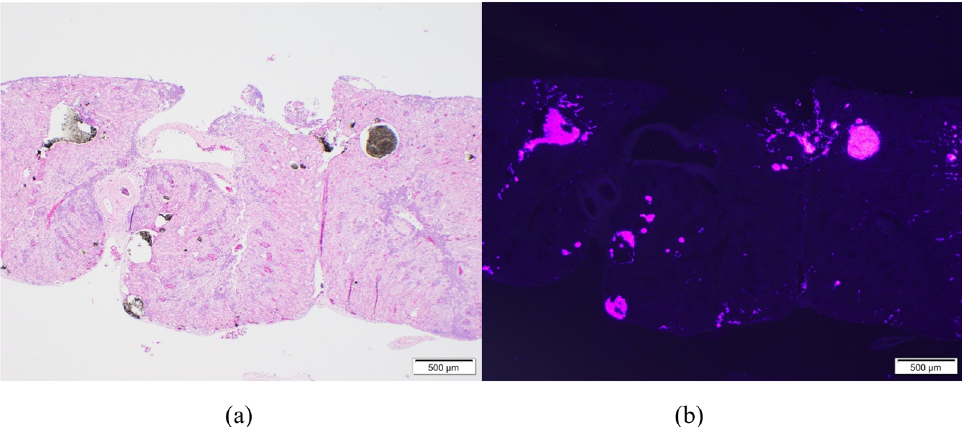
Figure 2. Microscopic examination of the kidney of a marine toad ( Rhinella marina ) 62 days after visible implant elastomer (VIE) tagging in the right distal limb. 10× magnification shows migrated VIE material in the small vasculature (vasa recta) of the kidney causing distention of the vessels. ( a ) On standard light microscopy, VIE is characterized as dark granules while under UV light ( b ) the VIE material fluoresces pink.